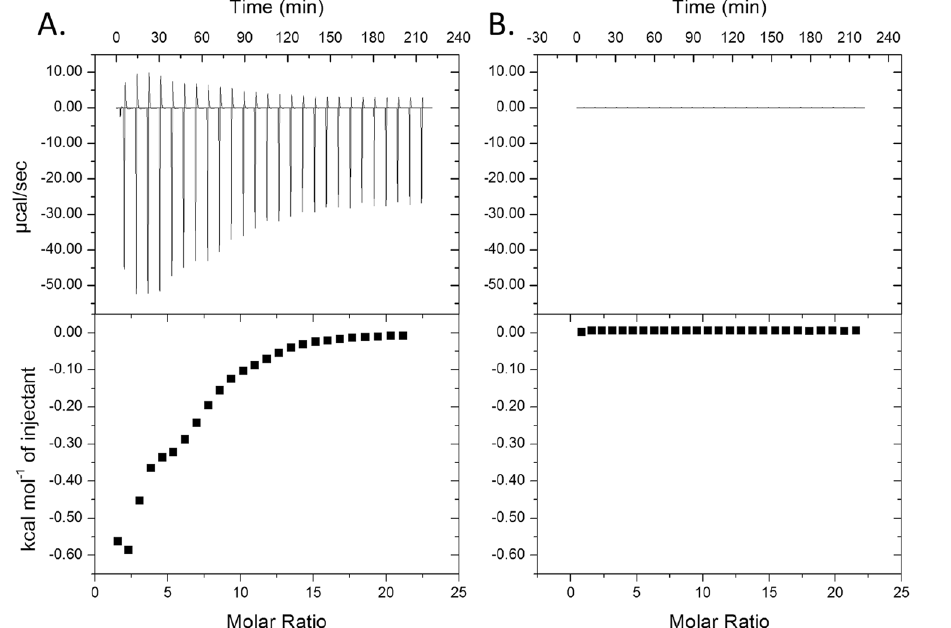
Figure 3. Unbuffered POA gives a robust ITC signal when titrated into neutral buffer. Saturated POA (( A ) unadjusted pH 2.3; ( B ) pH adjusted to 7.4) was injected into 10 mM phosphate buffer (pH